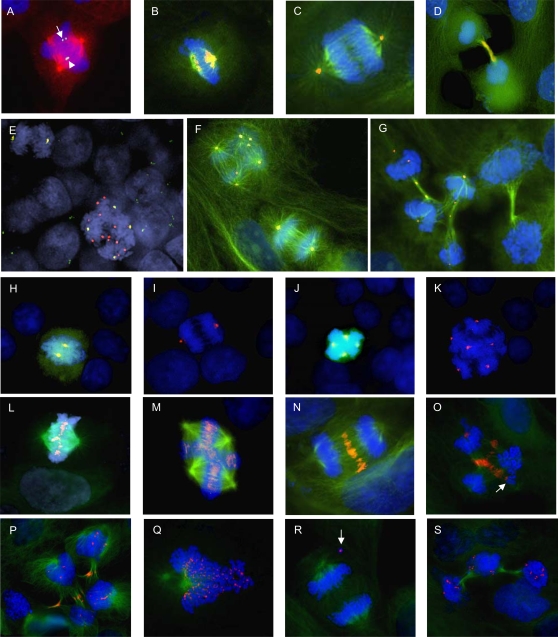
Sister chromatid separation and spindle assembly checkpoint proteins.FISH detection (A) of the chromosome 17 centromere (green) combined with immunofluorescence for beta tubulin (red) shows separation of the sister centromeres of one (arrow) but not of the other homologue (arrowhead). Immunofluorescence detection of separase (orange) and beta tubulin (green) shows localization of separase to spindle poles at metaphase (B) and early anaphase (C) and weak intensity staining in the midbody at telophase (D). Co-localisation of separase (red) and centrosomes (gamma tubulin in green) is observed at early bipolar anaphase (E, upper left) while several additional separase foci are present in an adjacent tetrapolar early anaphase cell (E, lower right). Co-labelling of separase (orange) and beta-tubulin (green) confirms this finding (F, tetrapolar at upper left and bipolar at lower right), and shows depletion of separase in a bipolar telophase cell (G, right) while several foci remain in a tetrapolar telophase cell (G, left). Immunofluorescence for CCNB1 (green) and AURKA (red) yields cytoplasmic staining in bipolar (H) and multipolar (J) metaphase cells while no staining is observed in bipolar (I) and multipolar (K) anaphase cells; AURKA stains the pericentrosomal regions at both metaphase and anaphase. Immunofluorescence for beta tubulin (green) and AURKB (red) shows localization of AURKB exclusively to centromeres at bipolar (L) and multipolar (M) metaphase, and exclusively to the spindle midzone at bipolar anaphase (N); in contrast, multipolar ana-telophase cells (O, P) exhibit AURKB in the midzone as well as on several chromosomes, indicating failure to separate the sister chromatids of some chromosomes (O, arrow). Immunofluorescence for beta tubulin (green) and MAD2L1 (red) shows MAD2L1 localization to centromeres at bipolar prometaphase (Q); at bipolar ana-telophase MAD2L1 foci is only present in chromosomes not incorporated in the mitotic process (R, arrow), whereas, at multipolar ana-telophase, multiple MAD2L1 foci are present on chromosomes (S).